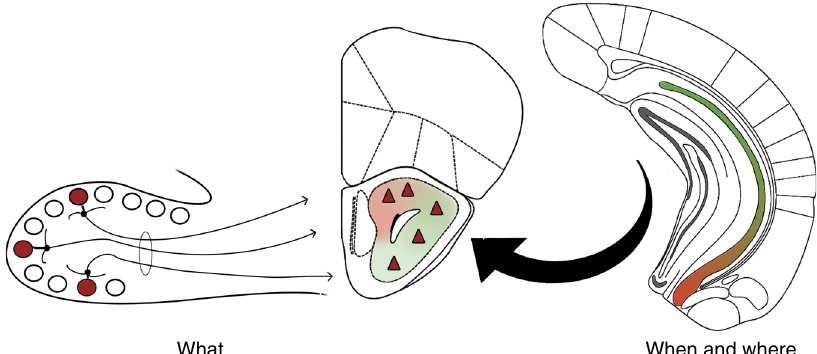
What When and where Fig. 5 Conceptual diagram for the formation of episodic odour memory. A model of episodic odour memory whereby information regarding odour quality and spatiotemporal context merge at the level of the AON producing cellular populations that represent previously encountered odours (what) within the context in which they occurred (when